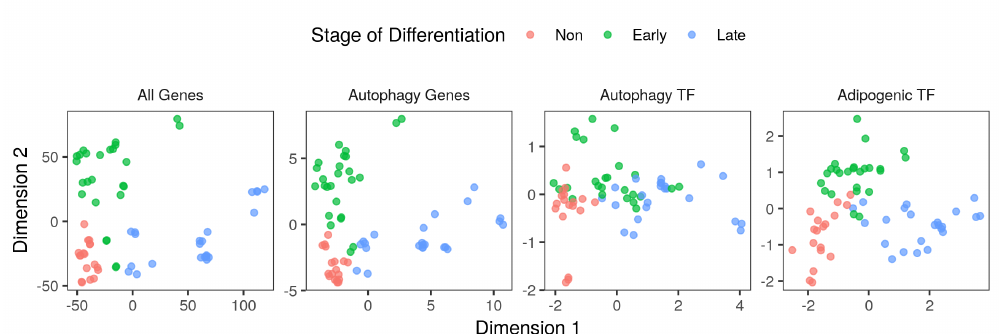
Figure 2. Multidimensional scaling analysis of gene expression. The transformed read counts of 15,786 genes coding, 158 autophagy genes, six genes encoding autophagy transcription factors ( Foxo1 , Irf8 , Tfeb , Trp53 , Xbp1 and Zkscan3 ) and five genes encoding adipogenic transcription factors ( Cebpb , Ep300 , Med1 , Pparg and Rxrg ) were used to perform multidimensional scaling (MDS). Counts were extracted from RNA-Seq samples (n = 66) of MDI-induced 3T3-L1 cells in three differentiation stages; 18 non (red), 25 early (green) and 23 late (blue) differentiating